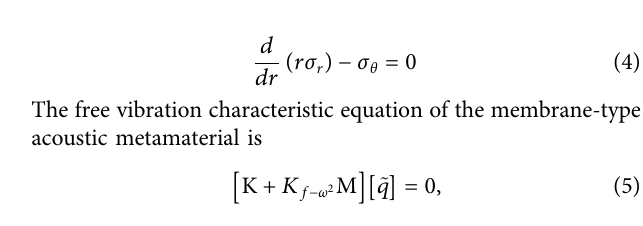
FIGURE 1 | Diagrams of various parts of an active acoustic material fi lm: (A) additional mass block, (B) aluminum frame, (C) magnetic fi lm, and (D) overview of the whole fi